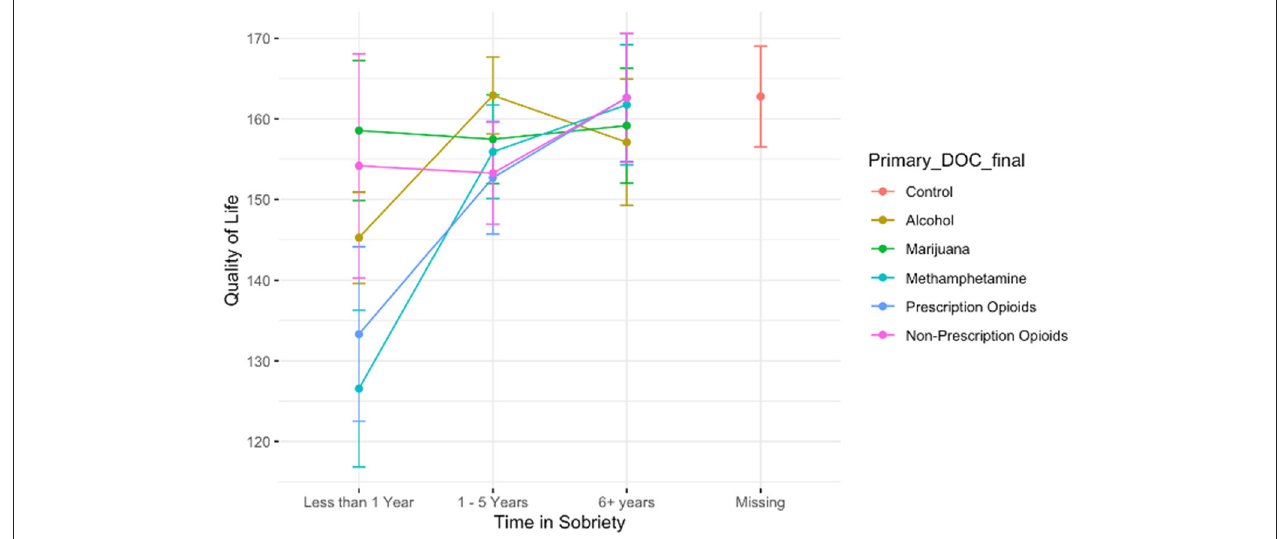
FIGURE 7 | A plot showing the trend that the longer time a person spends in recovery/sobriety, the higher their reported Quality of Life. There is no difference between Quality of Life among the control participants and any of those who have been in sobriety/recovery for six or more years. The highest increases in quality of life from early to later recovery are among those who used methamphetamine or prescription